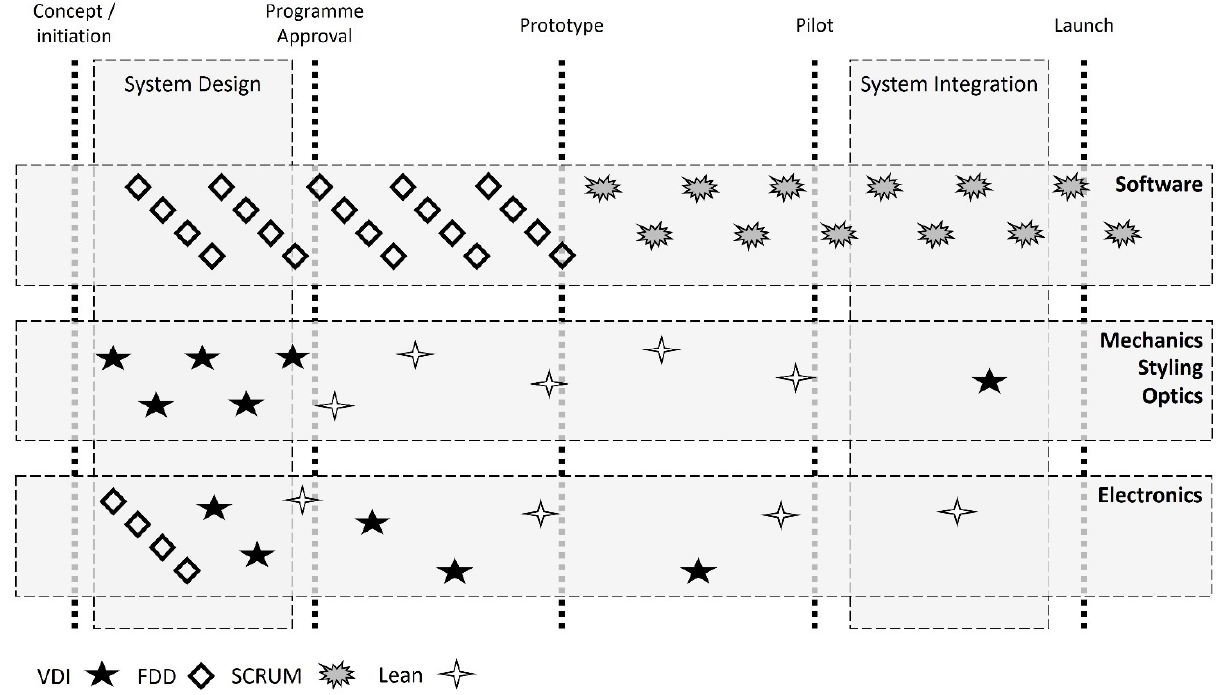
Figure 6. Model for LED-based Headlight development.